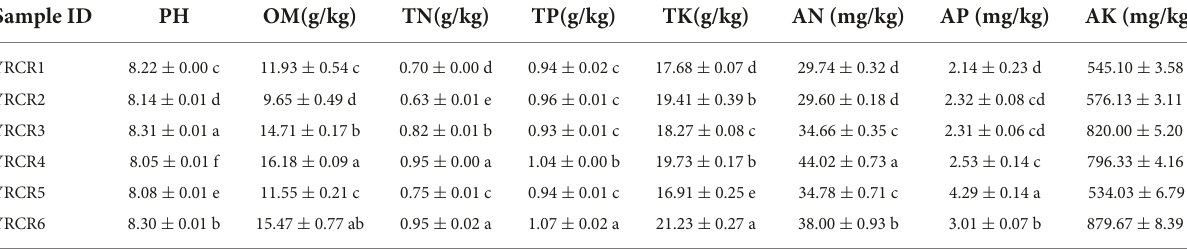
TABLE 1 Physical and chemical characteristics of different soil samples.